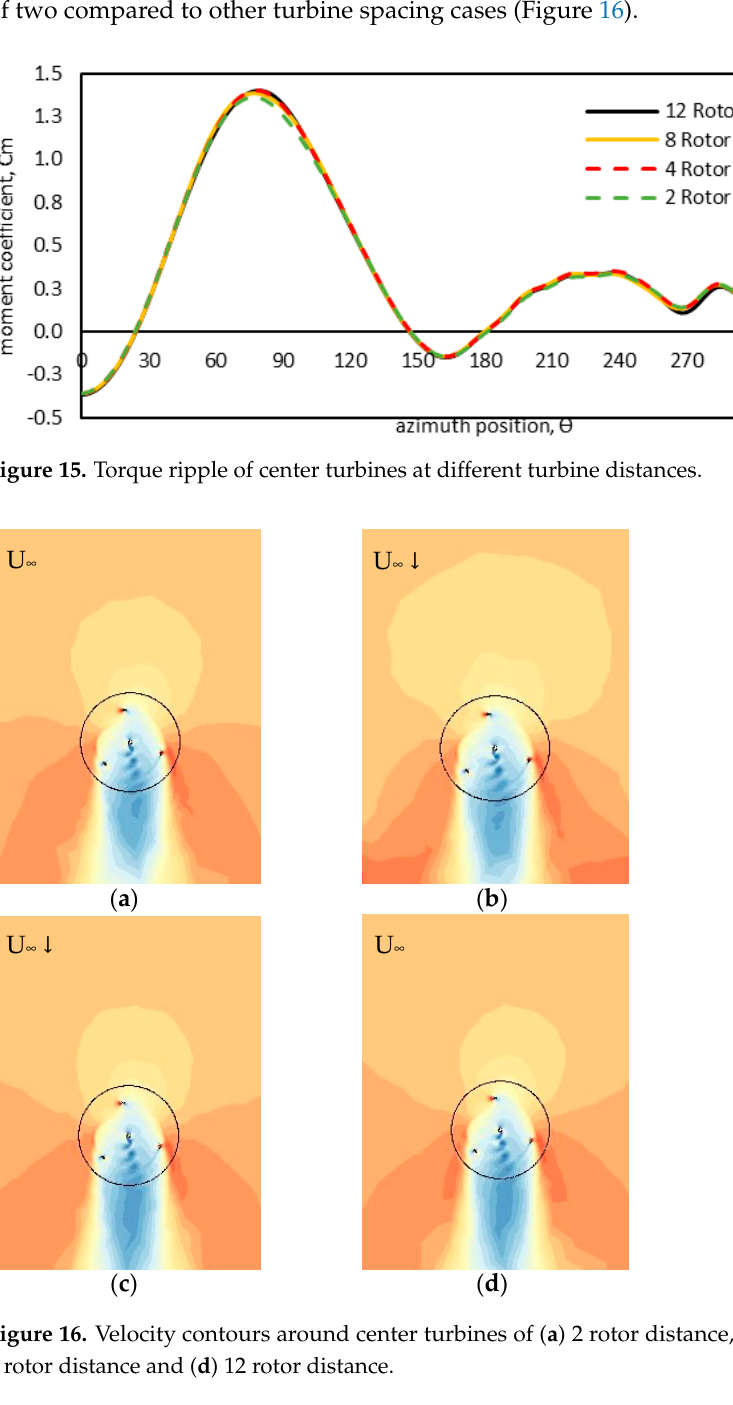
Figure 14. Torque ripple at 2 rotor distance configuration.